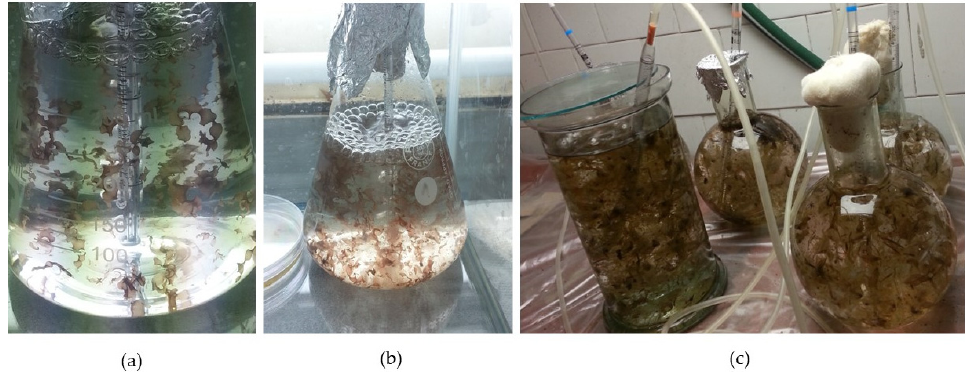
Figure 6. P. leucosticta cultures at 15 °C: ( a ) after 3 months; ( b ) after 4 months; ( c ) after 5 months .